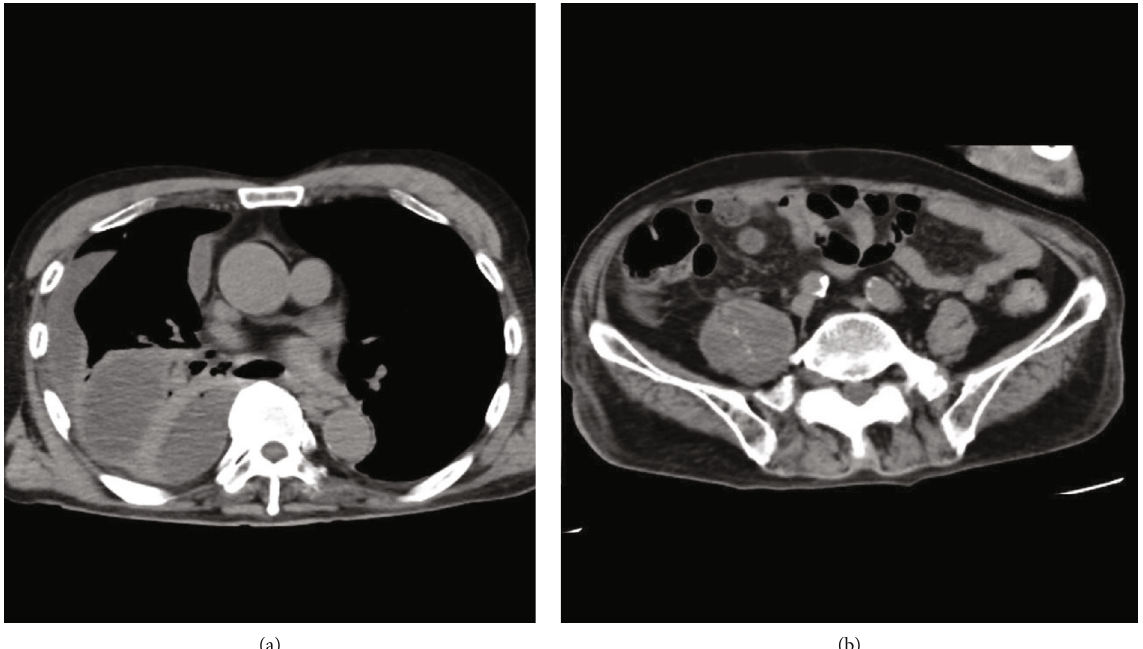
Figure 2: Truncal computed tomography (CT) fi ndings on arrival. Truncal CT (axial section) suggested right multilobular empyema (a) and right iliopsoas abscess